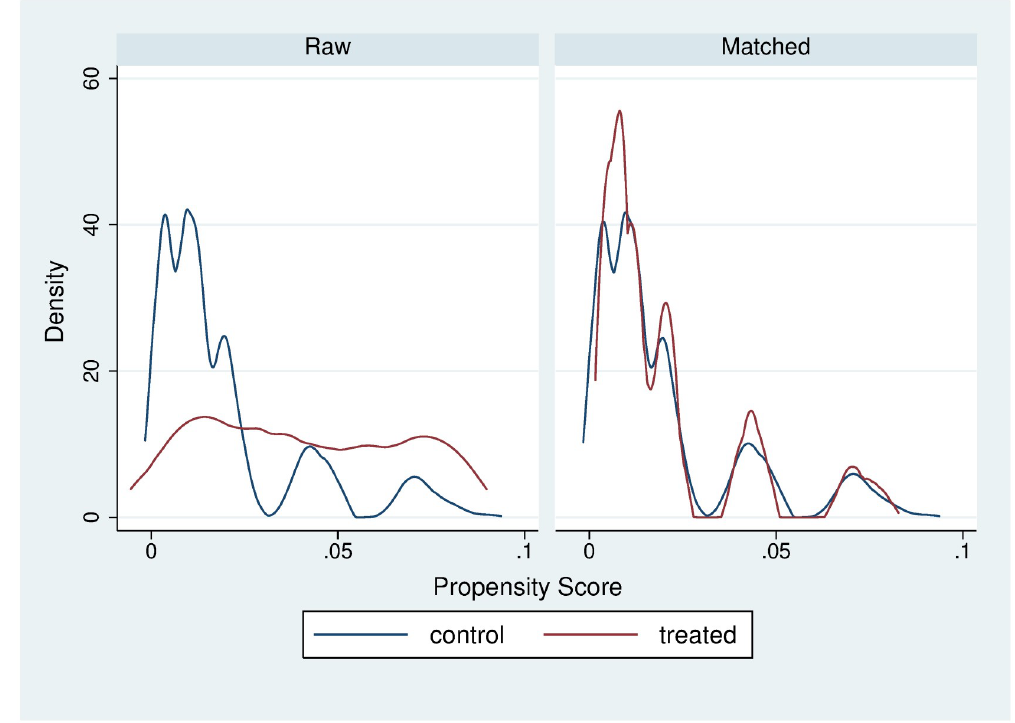
Fig 2. 6-nearest neighbor BMI matching balance.